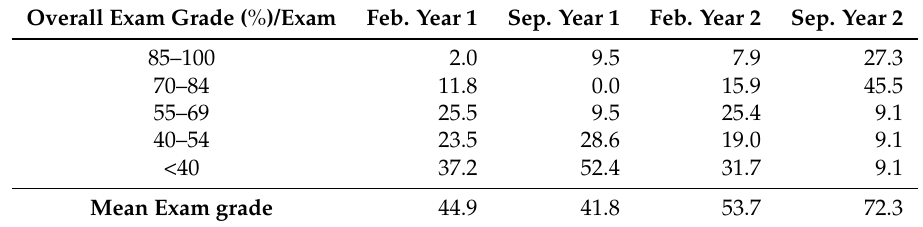
Table 4. Final exam student’s performance distribution (%), from February of the first academic year to September of the second academic